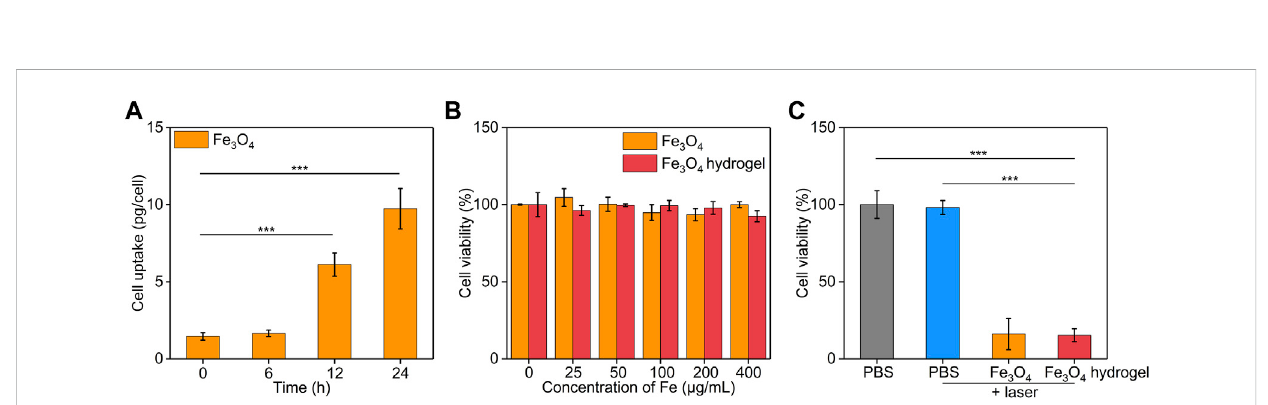
FIGURE 5 In vitro treatment ef fi cacy evaluation. (A) Cellular uptake assay of Fe 3 O 4 nanoparticles by CT26 cancer cells. (B) Cell viability of CT26 cancer cells